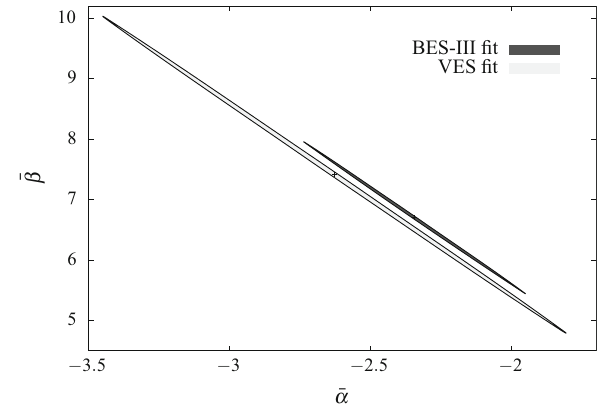
Fig. 6 Error ellipses for the DR 3 fits to BES-III and VES in the plane of the rescaled subtraction constants ( ¯ α, ¯ β) , corresponding to 68 . 27% confidence regions